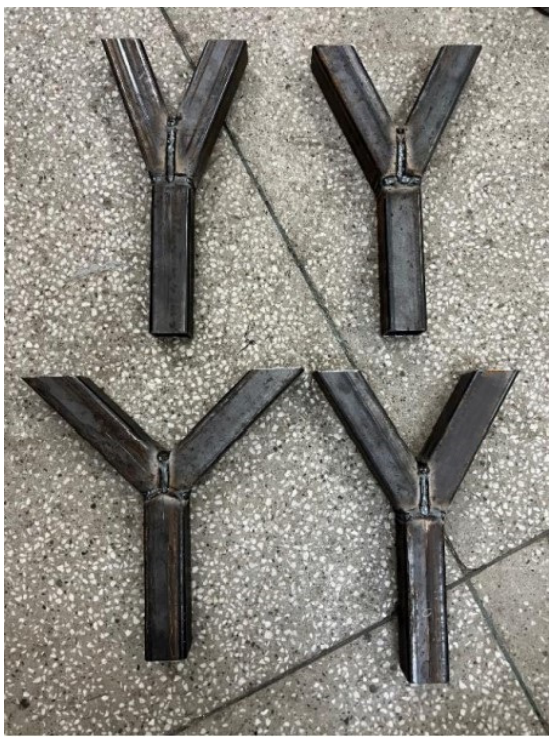
Figure 1. Specimens with different inclination